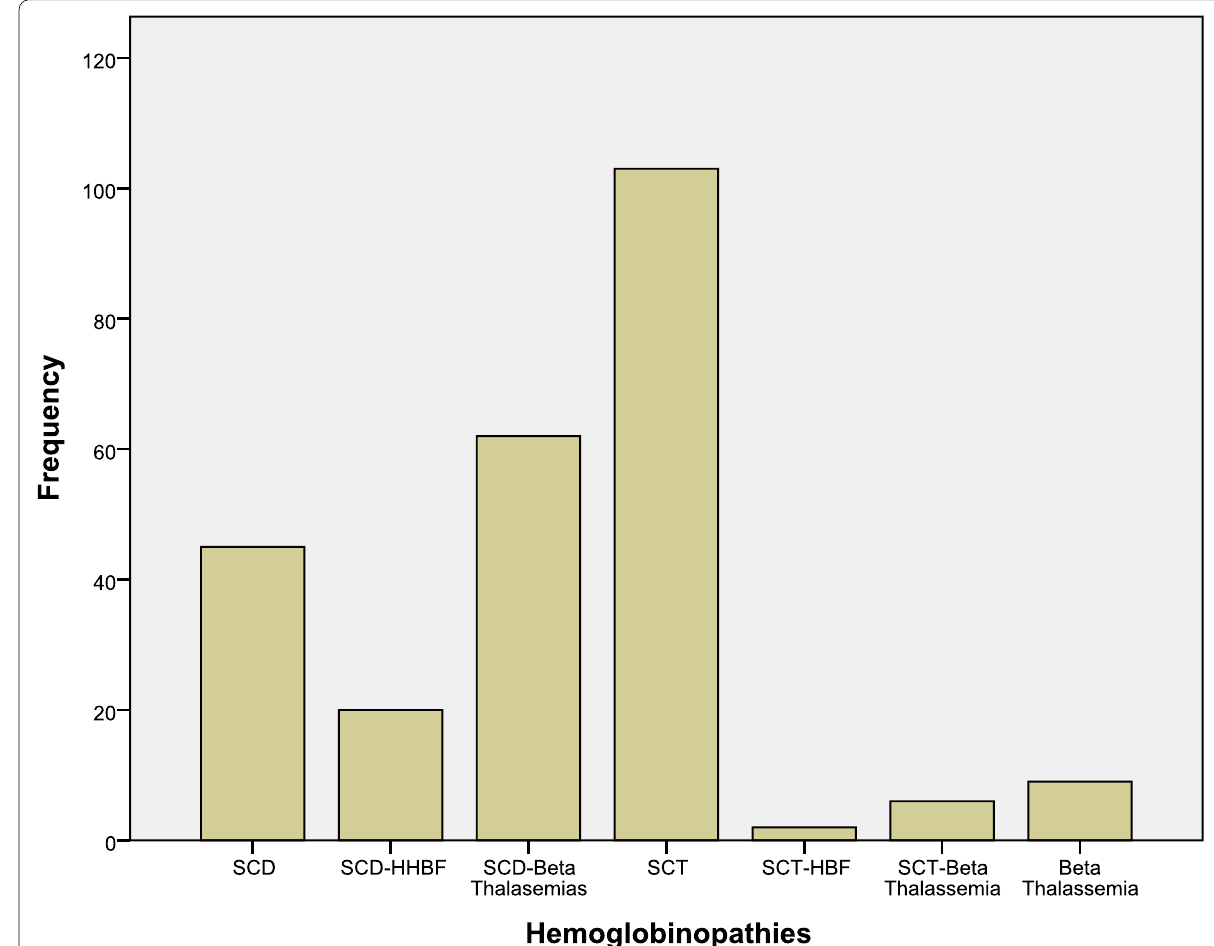
Fig. 1 Distribution of hemoglobinopathies among patients investigated at Aga Khan Hospital, Kisumu, and its satellite centers in Western